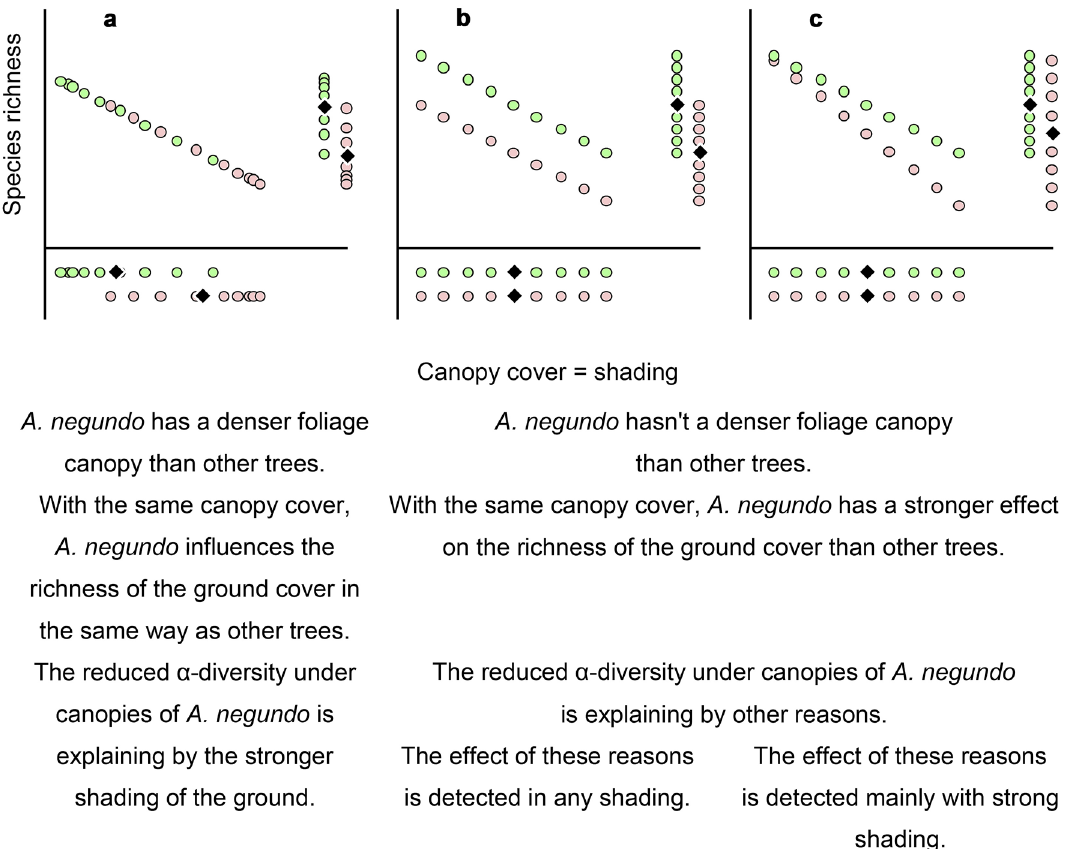
Figure 1. Hypothetical mechanisms of the generation of reduced diversity of the ground cover throughout shading in communities with Acer negundo (pink circles) in comparison with other trees (green circles); rhombus—average